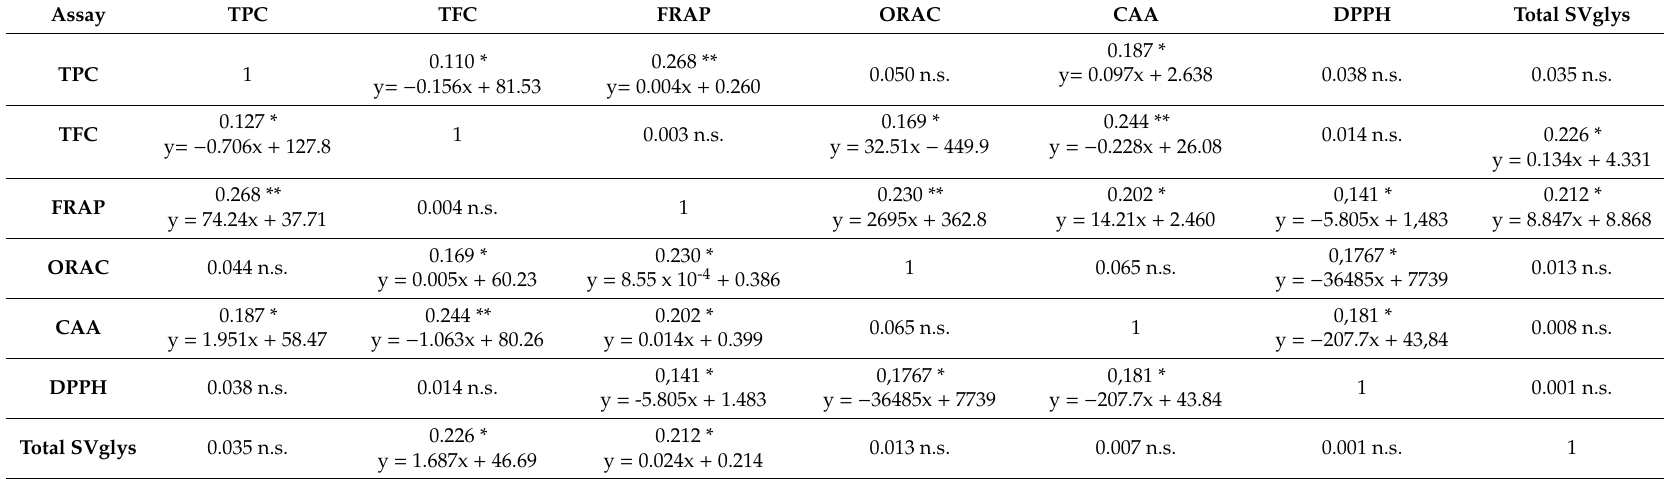
Table 2. Linear regression and Pearson coe ffi cient (r 2 ) among secondary metabolites (TPC, TFC and total SVglys) and antioxidant activity assays (FRAP, ORAC, CAA and